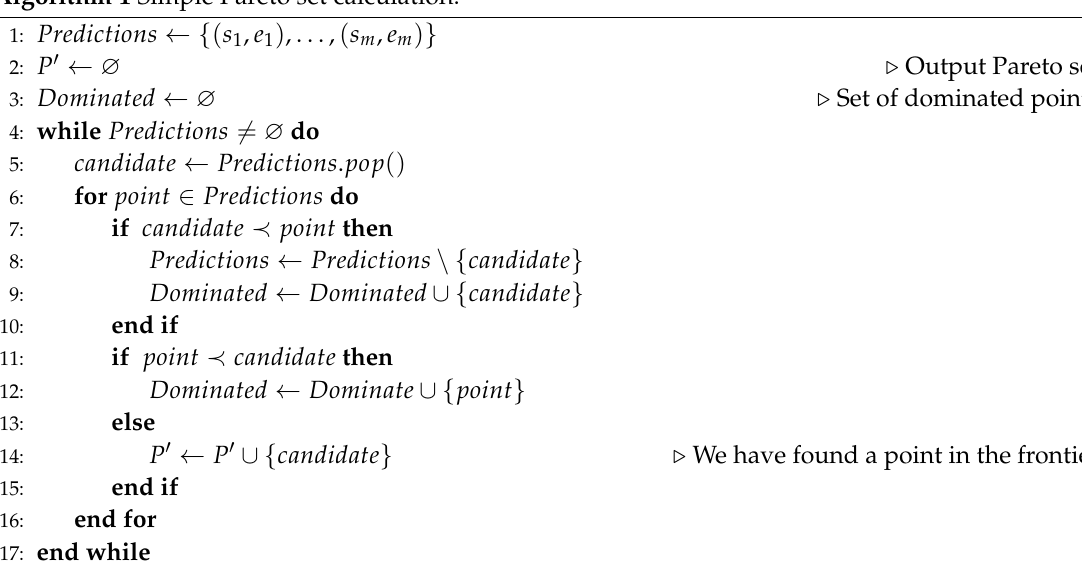
Algorithm 1 Simple Pareto set